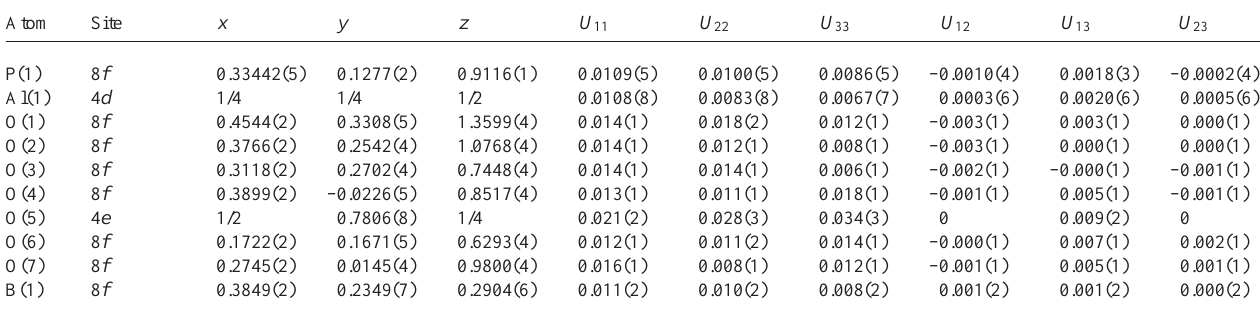
Table 3. Atomic coordinates and displacement parameters (in Å 2 )